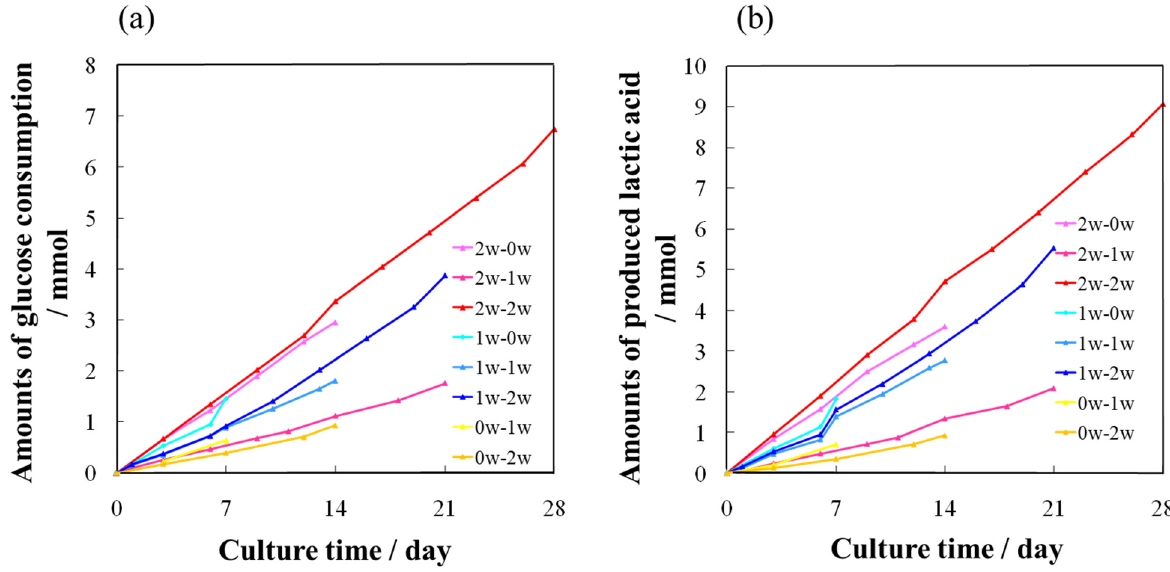
Figure 2. Culture conditions during the 3D culture using a RFB. ( a ) Glucose consumption and ( b ) lactic acid production with the culture period.